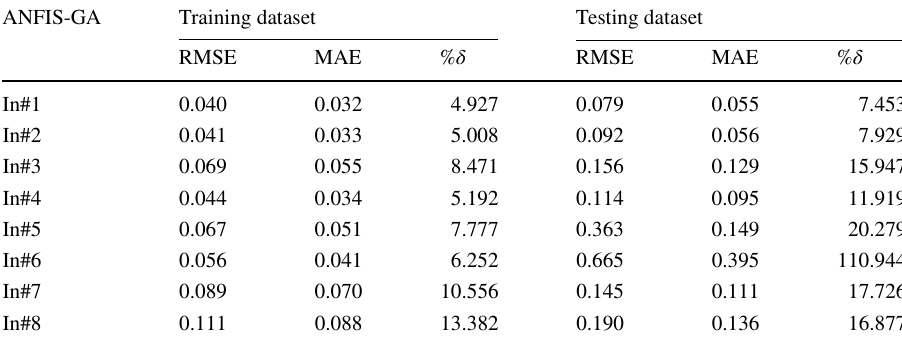
performance evaluation for various input combinations